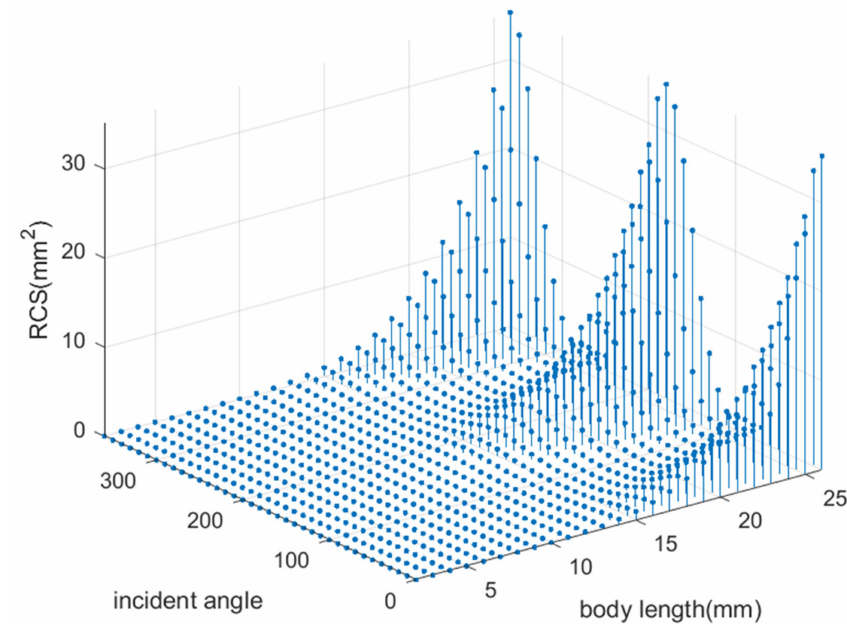
Figure 3. Schematic diagram of RCS database of individual